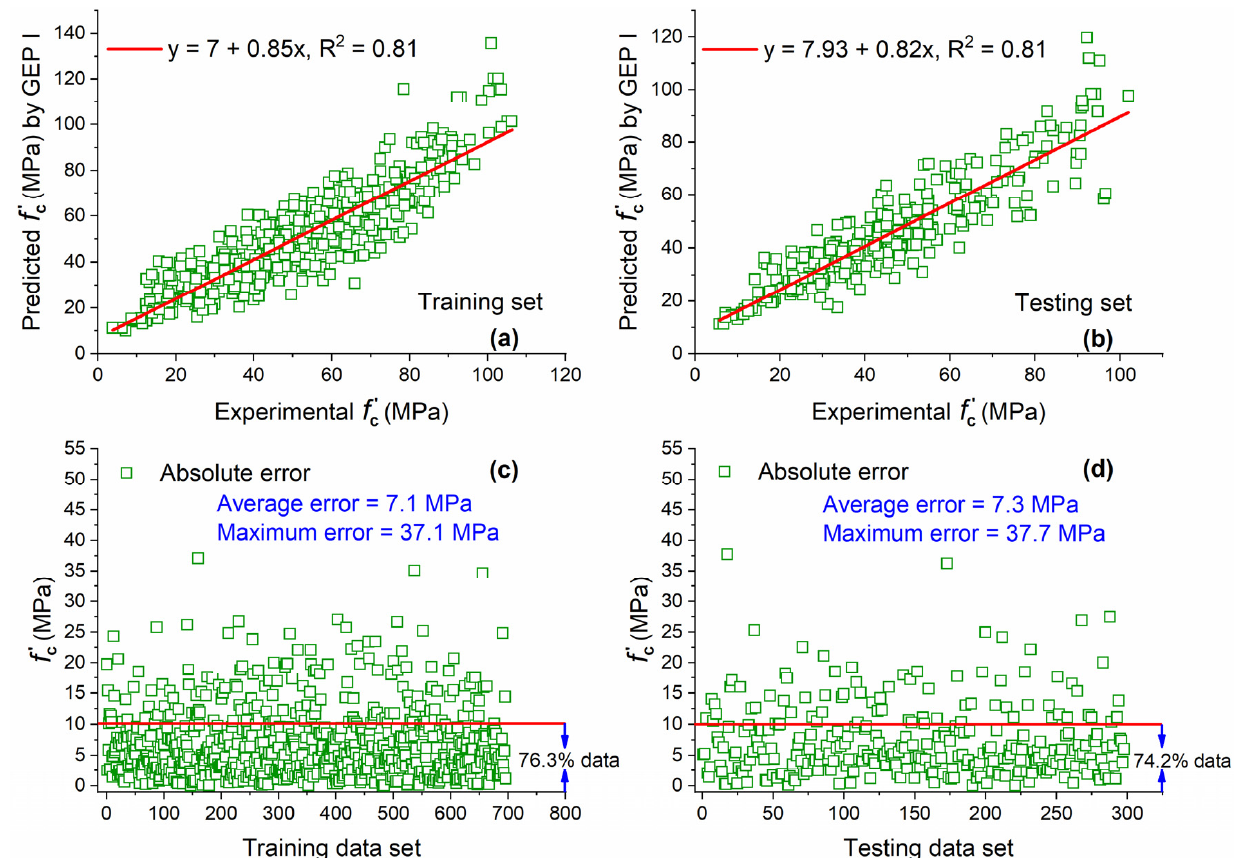
Figure 7. Experimental and predicted values of (cid:1858)′ (cid:2913) by GEP I for ( a ) training set and ( b ) testing set, and their corresponding absolute error for ( c ) training data set and ( d ) testing data set.